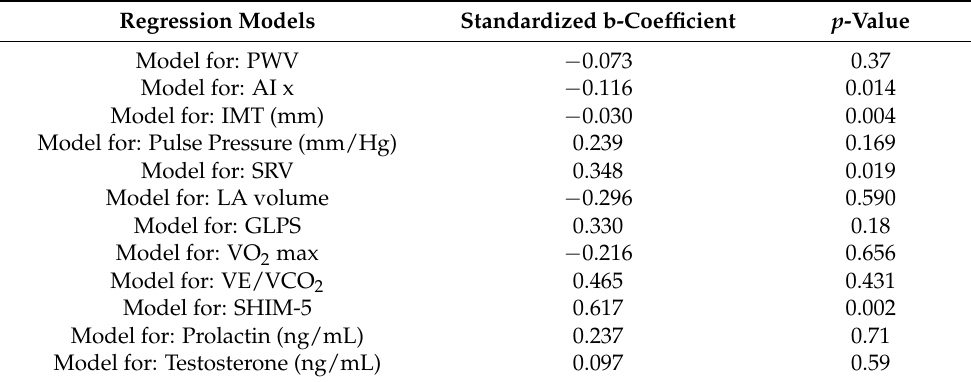
Table 2. Results from regression models that evaluated the role of Mediterranean diet adherence (through MedDietScore, independent variable) on cardiovascular hemodynamics factors (outcome), in chronic heart failure patients.